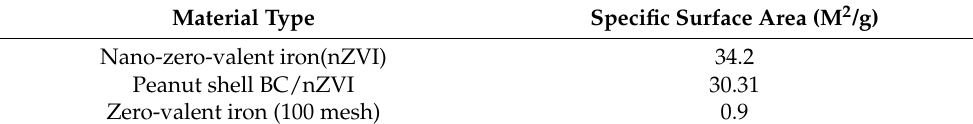
Table 1. Composite material specific surface area of peanut shell biochar, nano zero-valent iron, and zero-valent iron.